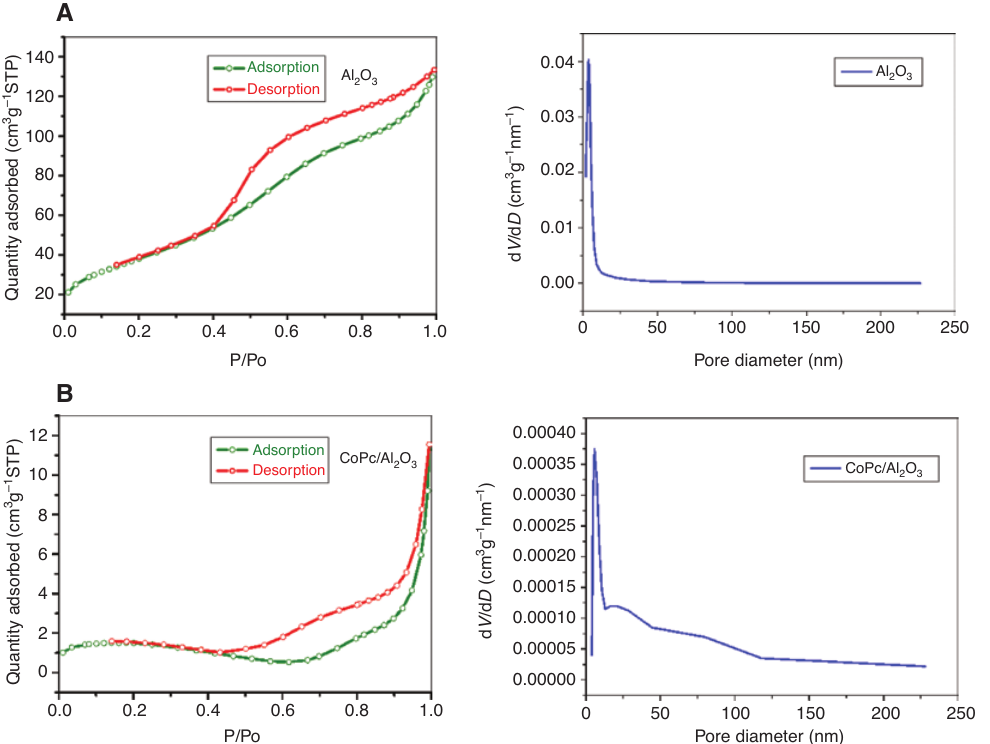
O (A) and CoPc/Al 2 3